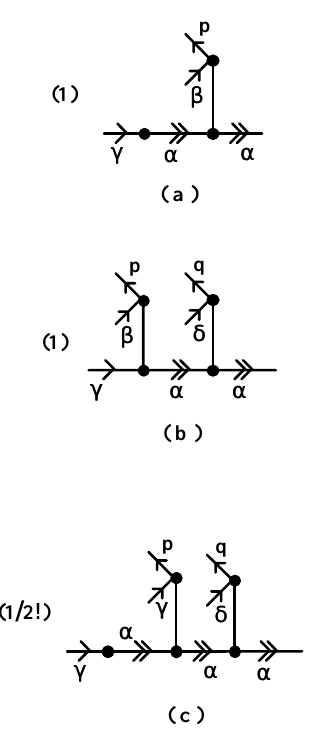
Figure 2: Connectivities of S e and S r operators, having different factors: (a) one-body S e and S S S r , (b) two-body e and r and (c) one-body indicated in the